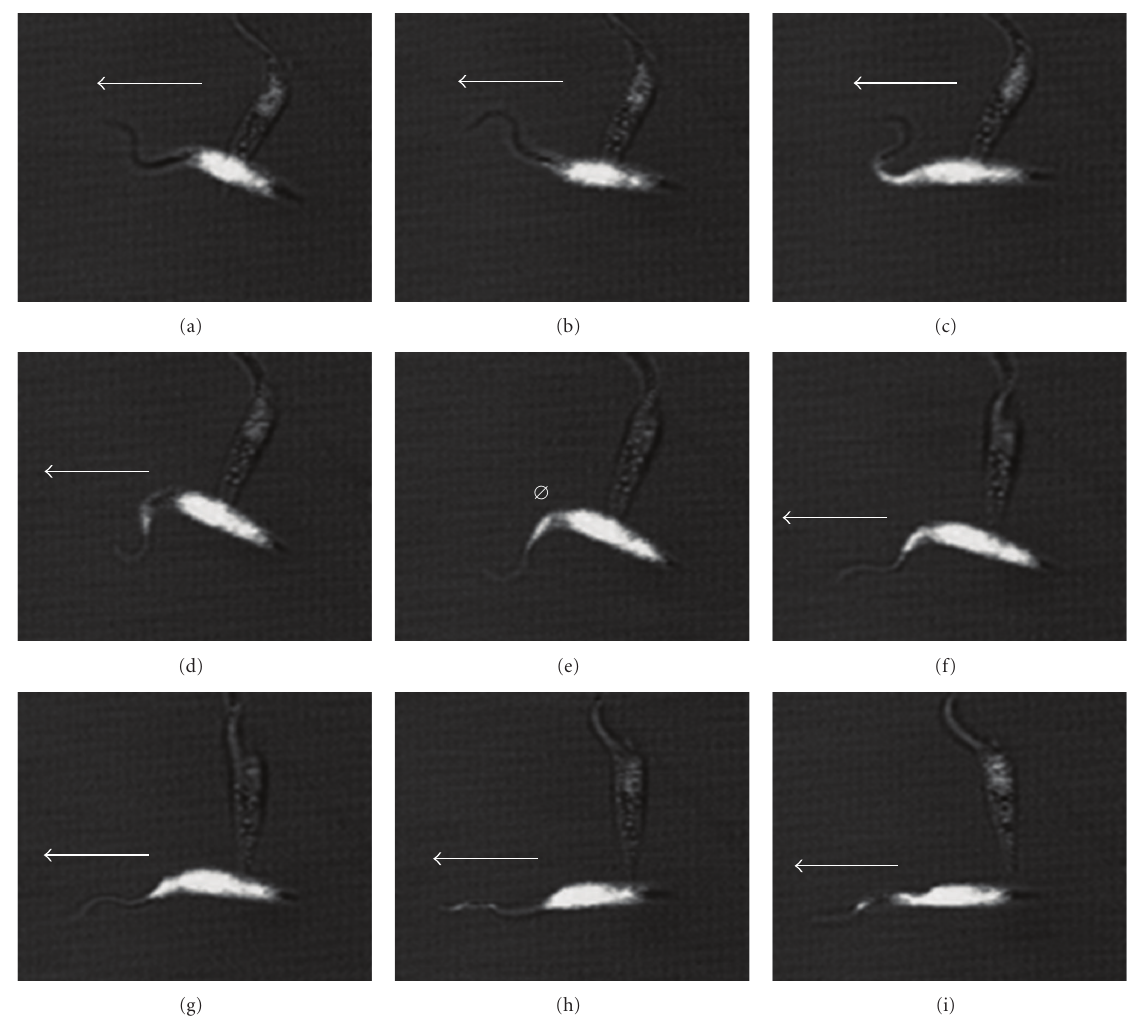
Figure 3: Illustration of the ciliary beat of T. cruzi. The forward parasite motility resulting from tip-to-base flagellar wave propagation (panels a–d) was interrupted by a sudden pause in which almost no movement of the parasite was observed (Ø). A base-to-tip wave propagation was observed before the parasite reinitiated the tip-to-base flagellar beat that resulted in a very little translational motion and clearly reoriented the parasite re-orientation and restarted the forward motion of the cell (panels f–i). These images correspond to those from an epimastigote obtained from the light blue region of Figure